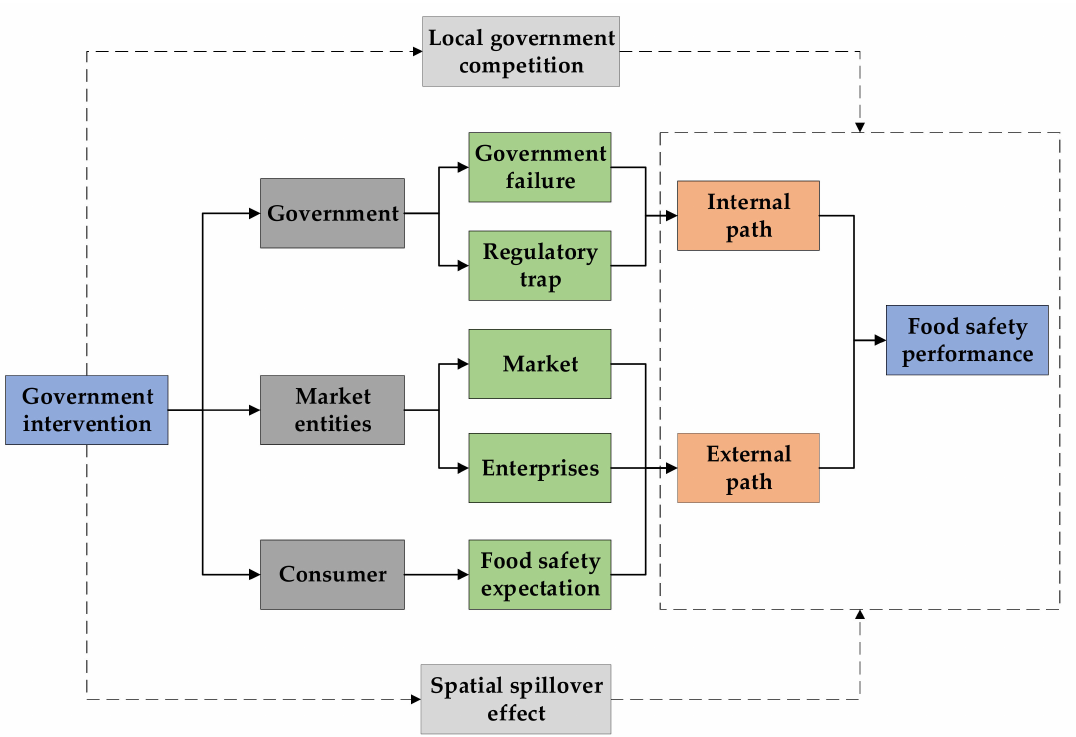
Figure 4. Mechanism path of government intervention on